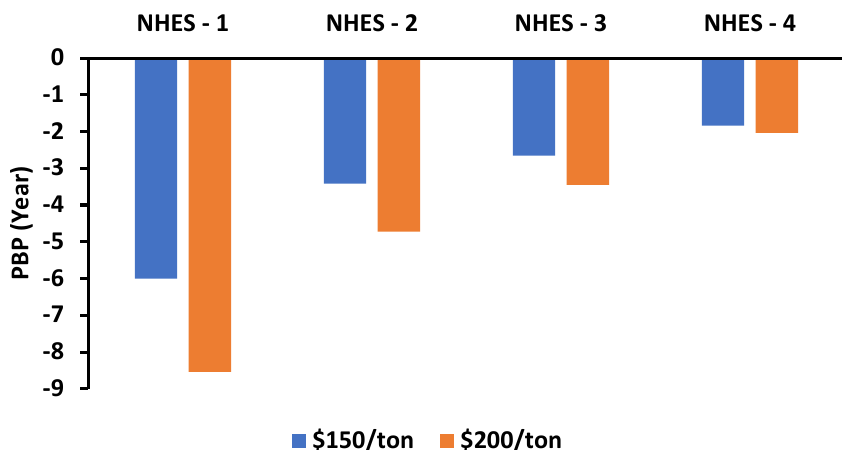
Figure 24. Difference in PBP based on increased carbon tax for PJM region .